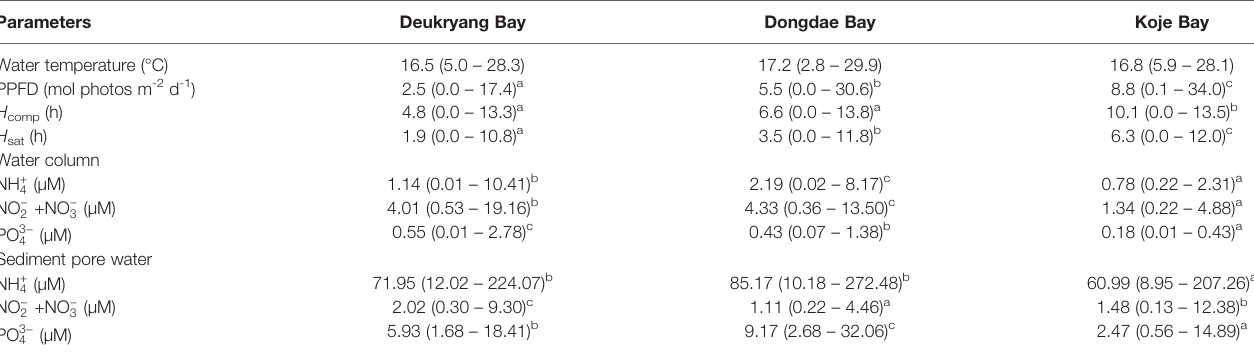
TABLE 1 | Water temperature, underwater photosynthetic photon fl ux density (PPFD), daily period of light compensation ( H comp ), daily period of light saturation ( H sat ), and nutrient concentrations in Deukryang Bay, Dongdae Bay, and Koje Bay on the southern coast of Korea.